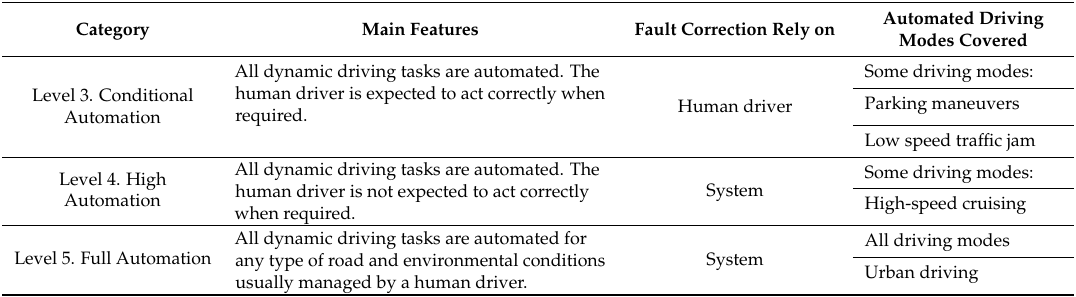
Table 2. Three categories of advanced driving